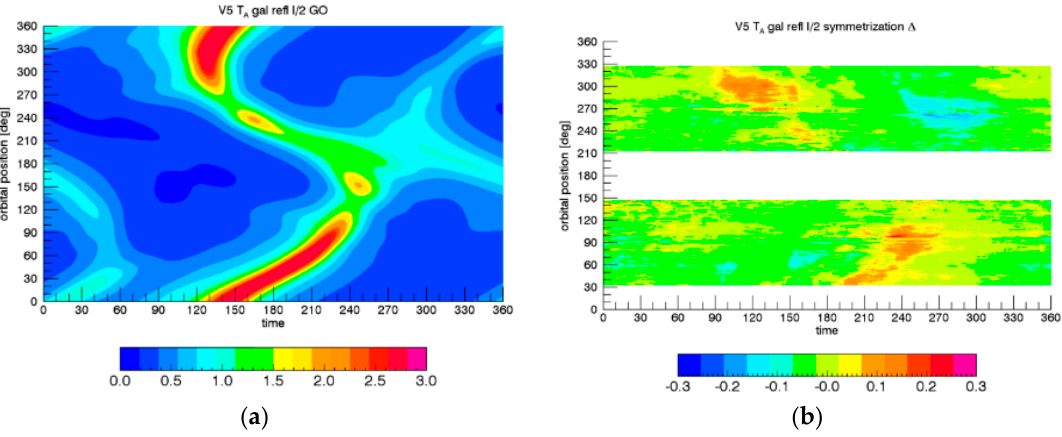
Figure 6. ( a ) Reflected galactic radiation computed from the GO model for an average wind speed of 7.5 m/s. ( b ) Value of the empirical symmetrization ∆ derived in this section. The figures show the + T ( T ) (in Kelvin) as function of time (day of year) and orbital position values of the averages 1 A , V A . H 2 1 ( ) ( z -angle) for Aquarius horn 2.